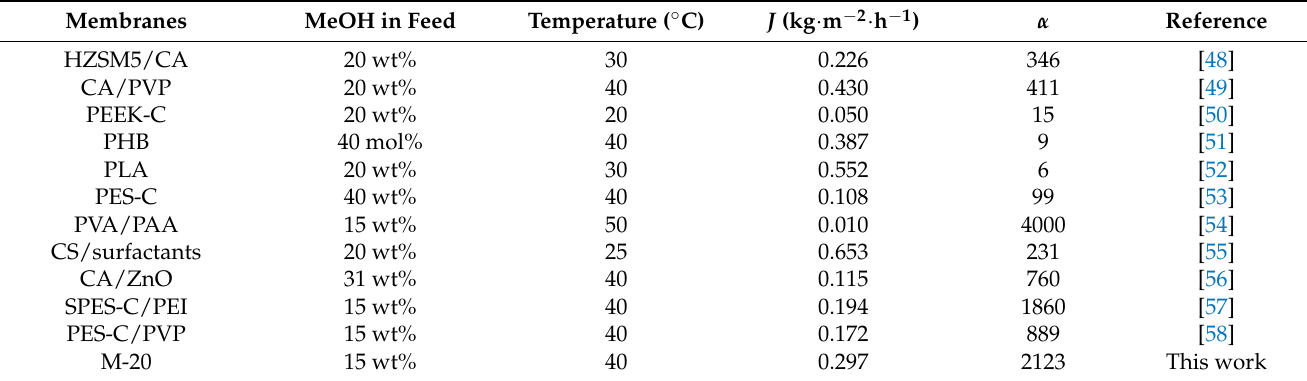
Table 1. PV performance comparison of MMMs in this work and in